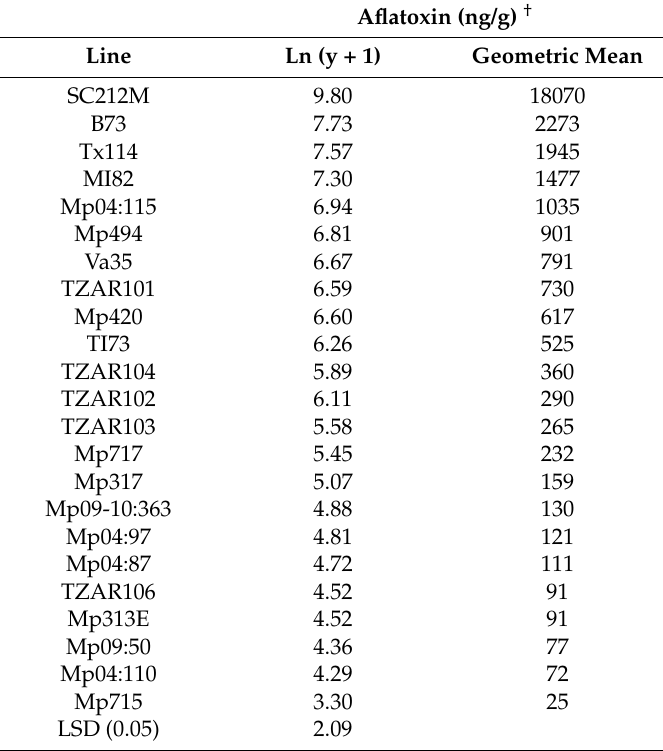
Table 1. Aflatoxin accumulation in germplasm lines evaluated at Mississippi State in